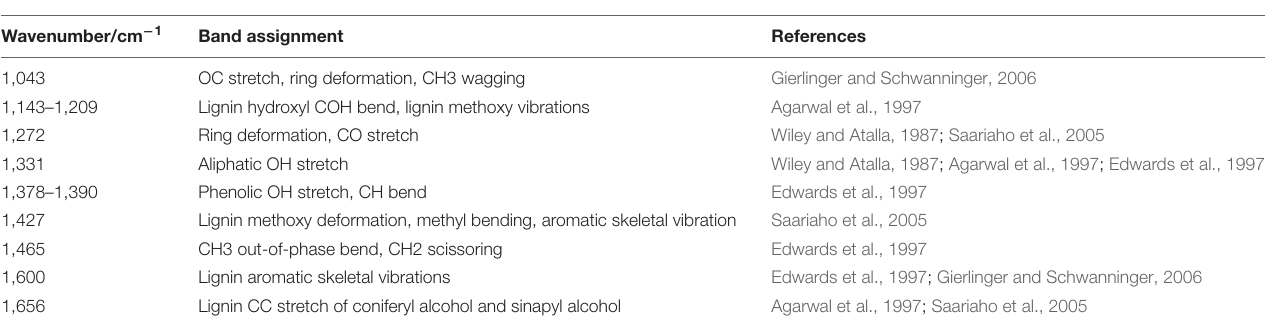
FIGURE 3 | Averaged Raman spectra in the range of 1,000–1,800 cm − 1 in different cell wall layers of tension wood (TW), opposite wood (OW), and normal wood (NW). (A) Averaged Raman spectra of the secondary wall layer, (B) averaged Raman spectra of the middle lamella, and (C) averaged Raman spectra of the cell corner. (D–F) Raman intensities at 1,275, 1,337, and 1,607 of TW, OW, and NW in the secondary wall layer, middle lamella, and cell corner, respectively. G, G lignin; H, H lignin; S, S lignin; L, total lignin; ns, not significant. Duncan’s method was used for multiple comparisons. TABLE 1 | The Raman bands used for analysis and their assignment to